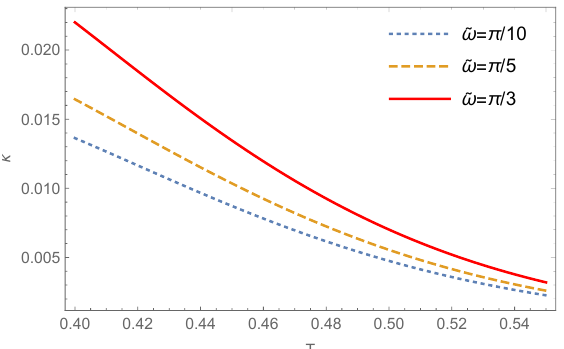
Figure 13 . The dependence of the transition rate of the Hawking-Page phase transition from the large SAdS black hole state to the thermal AdS state on the ensemble temperature T for the exponentially decayed friction kernel. In the plot, L = 1 , ζ = 5 , and γ = 1 . barrier height between the small SAdS black hole state at the top of the barrier and the large SAdS black hole state in the right potential well on the landscape. Increasing the ensemble temperature will elevate the barrier height and in turn slow down the